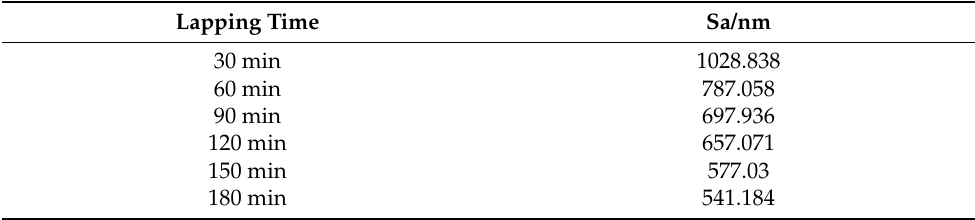
Table 5. The surface roughness of lapping quartz glass of FAP samples at each processing